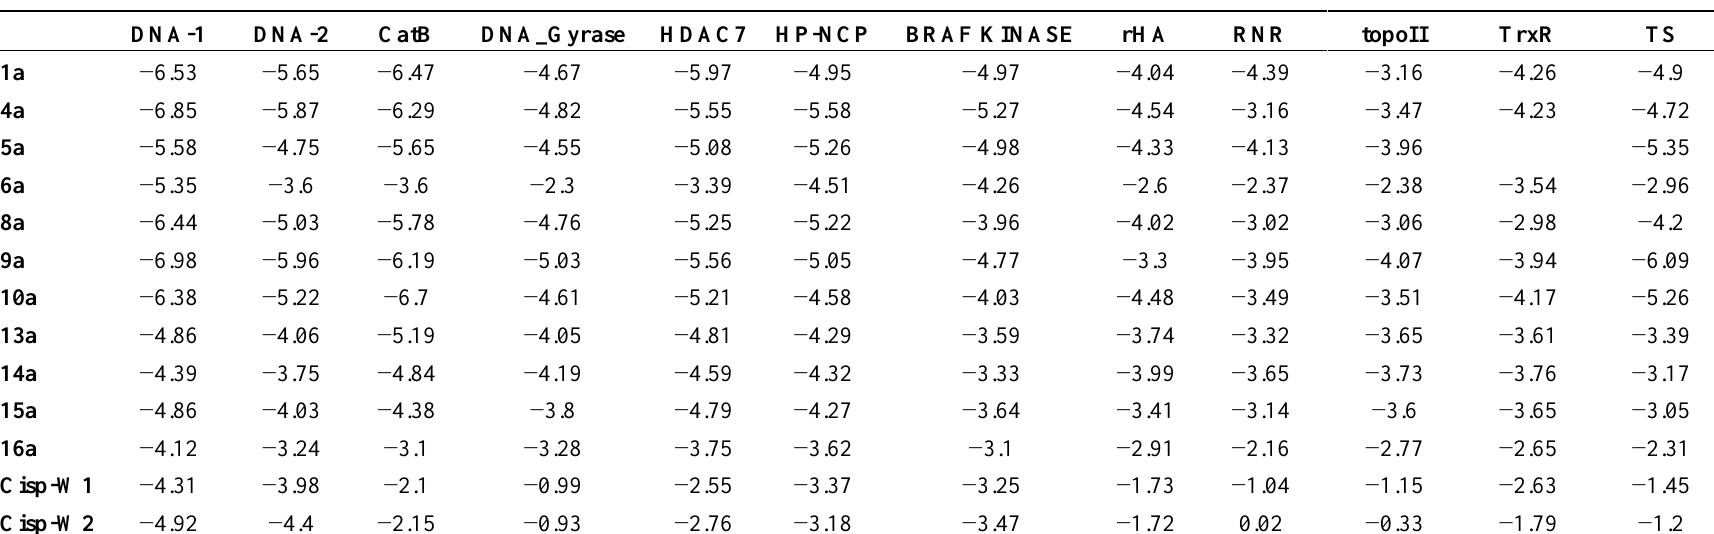
Table 3. The binding energy of the metallocompounds from the Autodock docking of hydrated complexes.